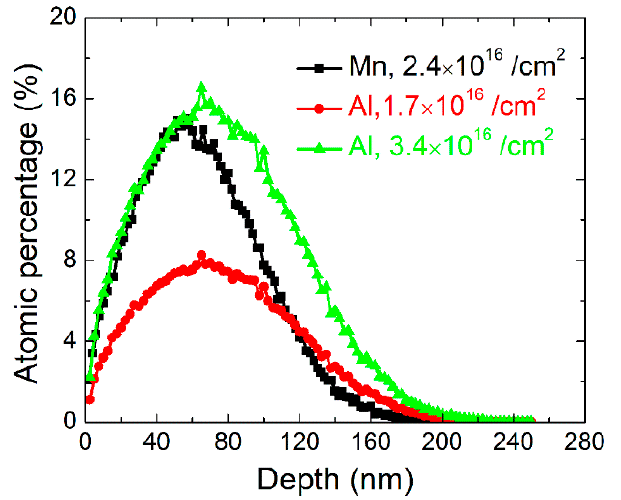
Figure 1. SRIM calculation of implanted Mn and Al distribution in InAs matrix.